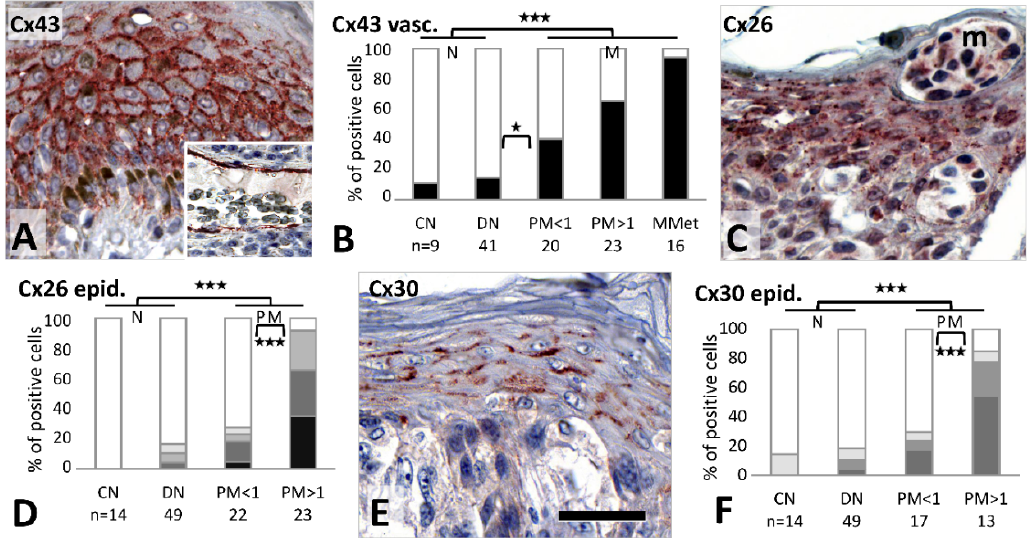
Figure 5. Connexin expression in melanocytic tumor microenvironment. Epidermal keratinocytes above a thick melanoma show Cx43 cell membrane reaction (red) in all layers besides melanocyte (brown) hyperplasia ( A ). Inset shows Cx43 positivity in lymphoid vascular endothelial cells of a metastatic melanoma. Summary of Cx43 expression in tumor adjacent vessels ( B ). Elevated granular Cx26 reaction in the epidermis surrounding melanoma nests (m) of a thick melanoma ( C ). Summary of tumor adjacent epidermal Cx26 expression ( D ). Cell membrane associated Cx30 reaction in suprabasal epidermal keratinocytes above a thin melanoma ( E ). Summary of tumor adjacent epidermal Cx30 expression ( F ). ( D and F : white, no expression; light gray, only in stratum granulosum; medium gray, in uppermost layers; dark gray, in suprabasal layers; black, in all layers). Scale bar on E is 40 μm long and it represents 50 μm on A (including inset) and B . *** p ≤ 0.001.